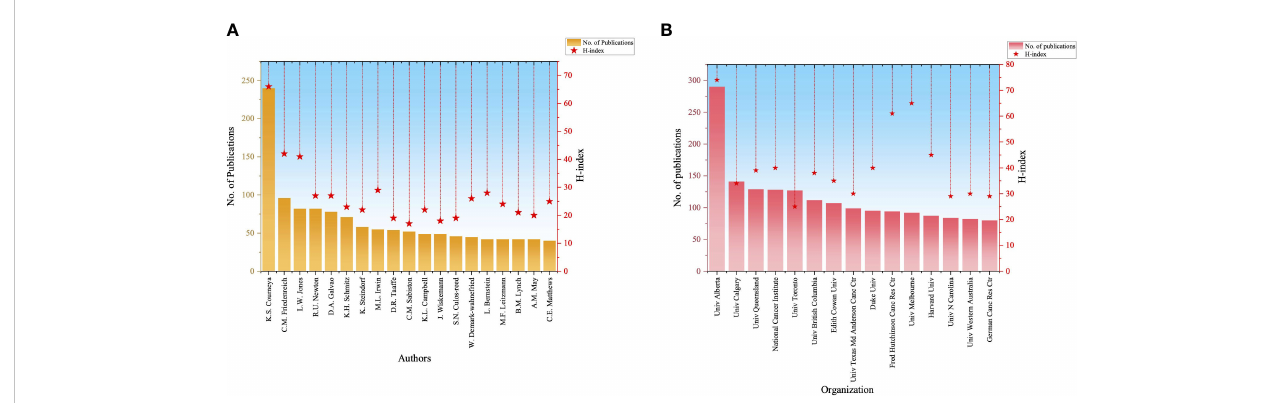
FIGURE 5 Distribution of the most in fl uential authors and institutions. (A) The most productive authors. (B) The most productive